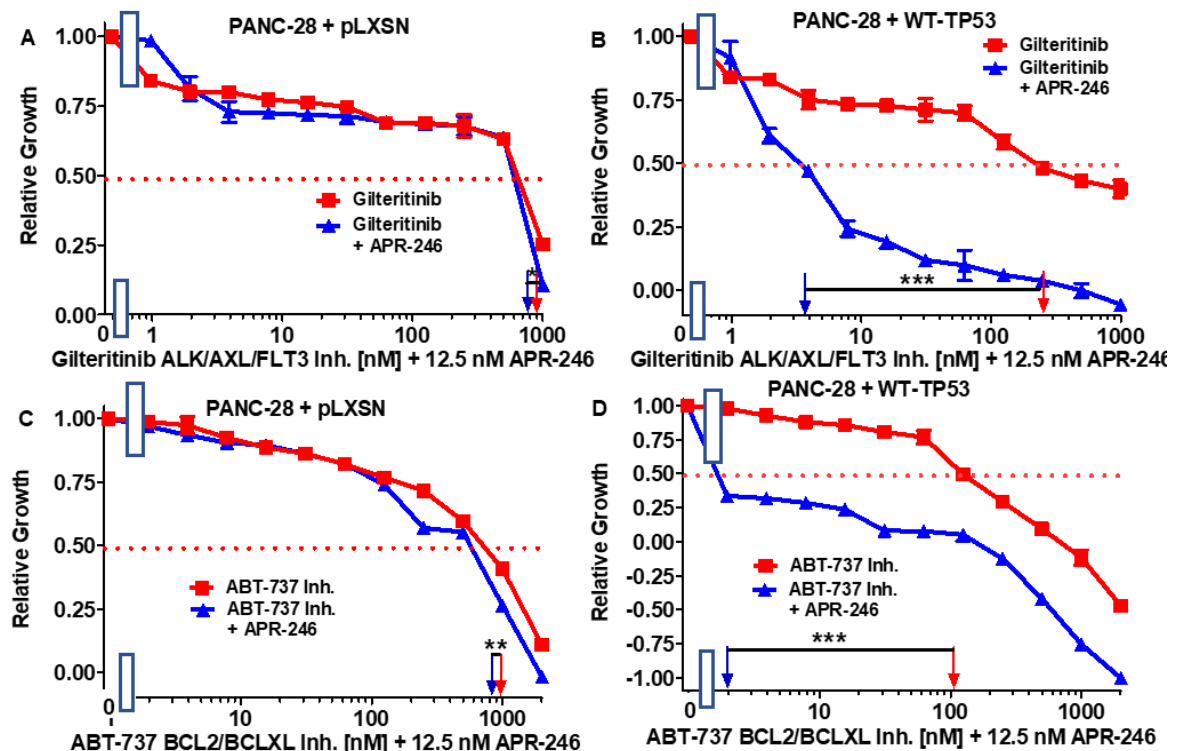
Figure 8. Effects of combining a constant concentration of 12.5 nM APR-246 on the IC 50 values of gilteritinib and ABT-737 in PANC-28 + pLXSN and PANC-28 + WT-TP53 cells. Panel ( A ) PANC-28 + pLXSN cells treated with different concentrations of gilteritinib (red squares) and PANC-28 + pLXSN cells treated with different concentrations of gilteritinib and a low dose of 12.5 nM APR-246 (blue triangles). Panel ( B ) PANC-28 + WT-TP53 cells treated with different concentrations of gilteritinib (red squares) and PANC-28 + WT-TP53 cells treated with different concentrations of gilteritinib and a constant dose of 12.5 nM APR-246 (blue triangles). Panel ( C ) PANC-28 + pLXSN cells treated with different concentrations of ABT-737 (red squares) and PANC-28 + pLXSN cells treated with different concentrations of ABT-737 and a low dose of 12.5 nM APR-246 (blue triangles). Panel ( D ) PANC-28 + WT-TP53 cells treated with different concentrations of ABT-737 (red squares) and PANC-28 + WT-TP53 cells treated with different concentrations of ABT-737 and a low dose of 12.5